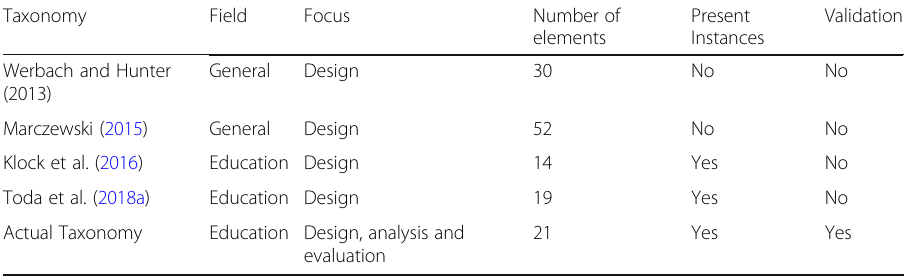
Table 1 Related works